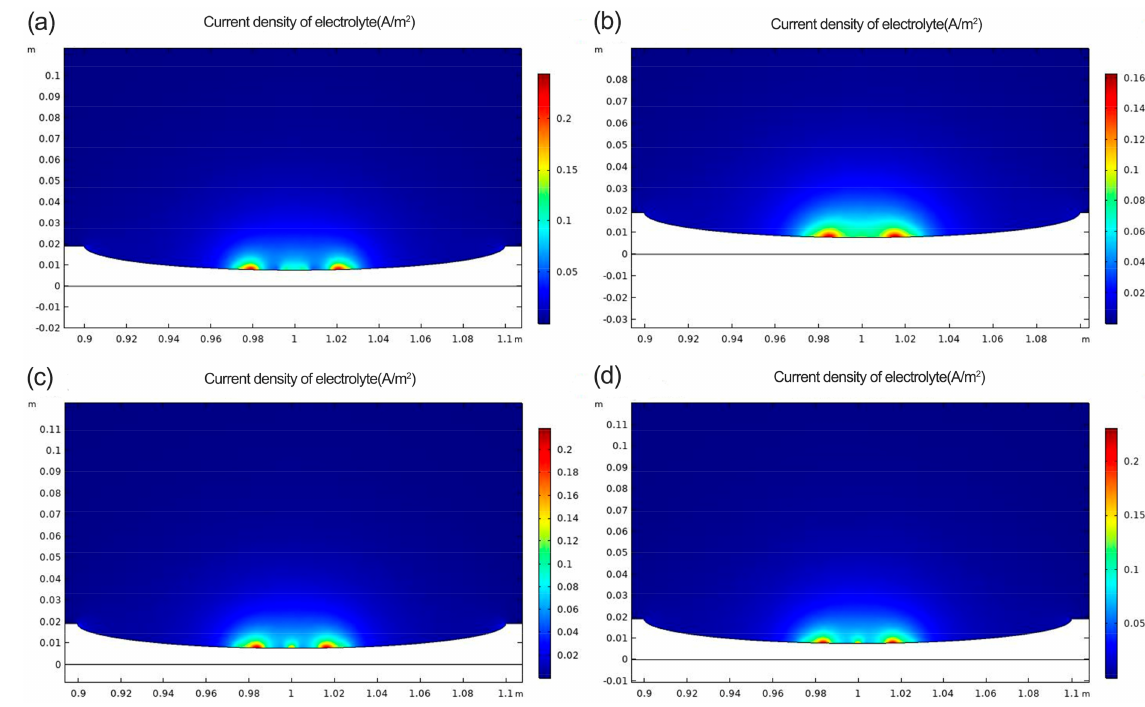
Figure 14. Current density diagram at 4 mm tensile displacement ( a ) No. 1 ( b ) No. 2 ( c ) No. 3 ( d ) No.